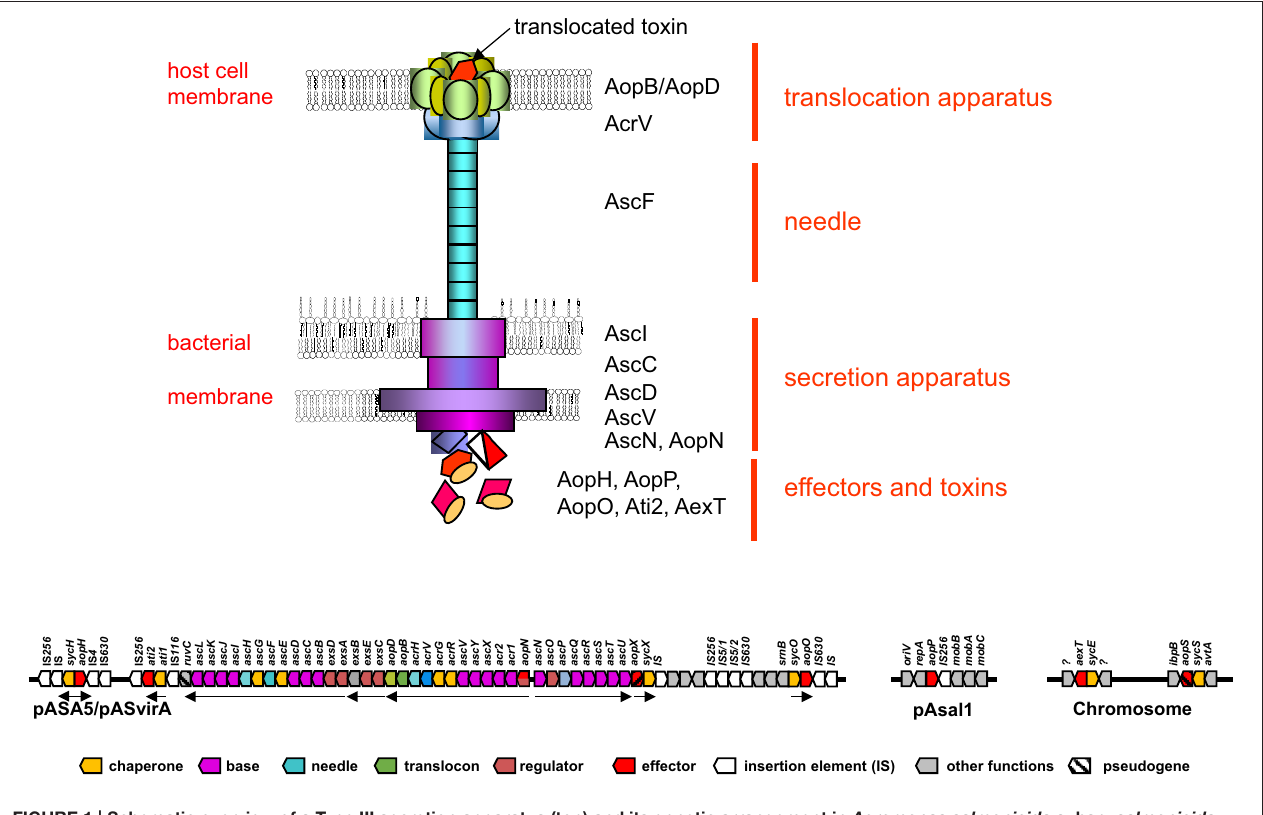
FIGURE 1 | Schematic overview of a Type III secretion apparatus (top) and its genetic arrangement in Aeromonas salmonicida subsp. salmonicida (bottom). The colored arrows represent the individual genes and are labeled with analogous colors of the constituents of the T3SS apparatus drawn on top. Black arrows indicate the major operons. Note only the prominent Asc proteins are indicated in the drawing on the top part of the figure. Data taken from: (Burr et al., 2003a; Reith et al., 2008; Cornelis, 2010; Galan et al., 2014).